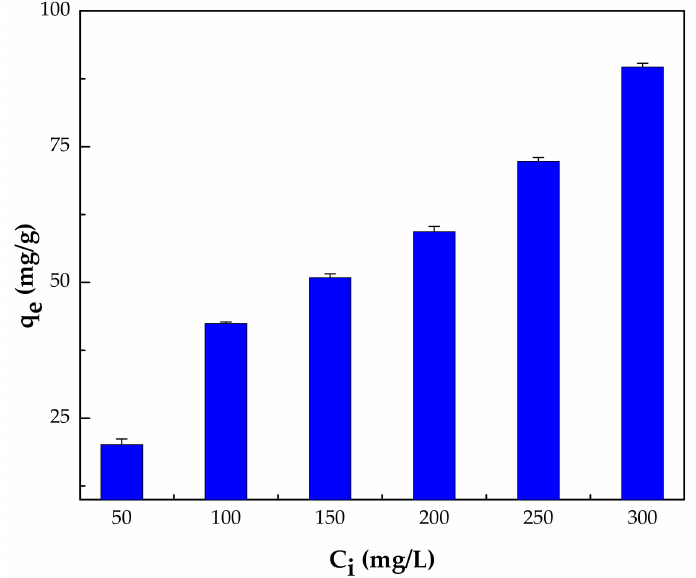
Figure 11. Effect of initial phenol concentration on the adsorption capacity (pH of 2, 150 rpm, 2 h, beads dosage = 1 mg/mL and at 25 ◦